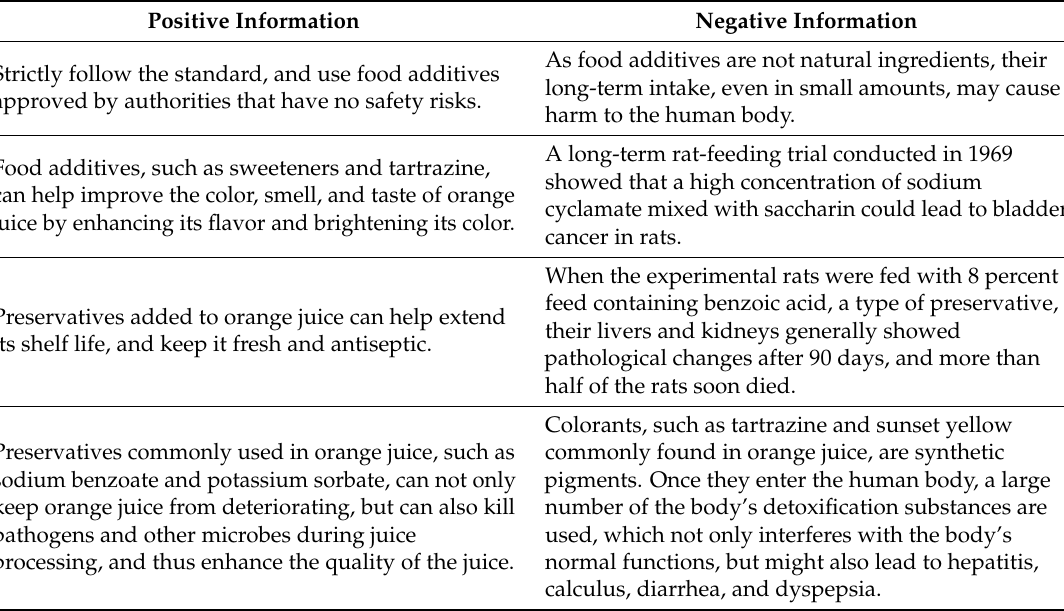
Table 2. Different types of information provided in experimental